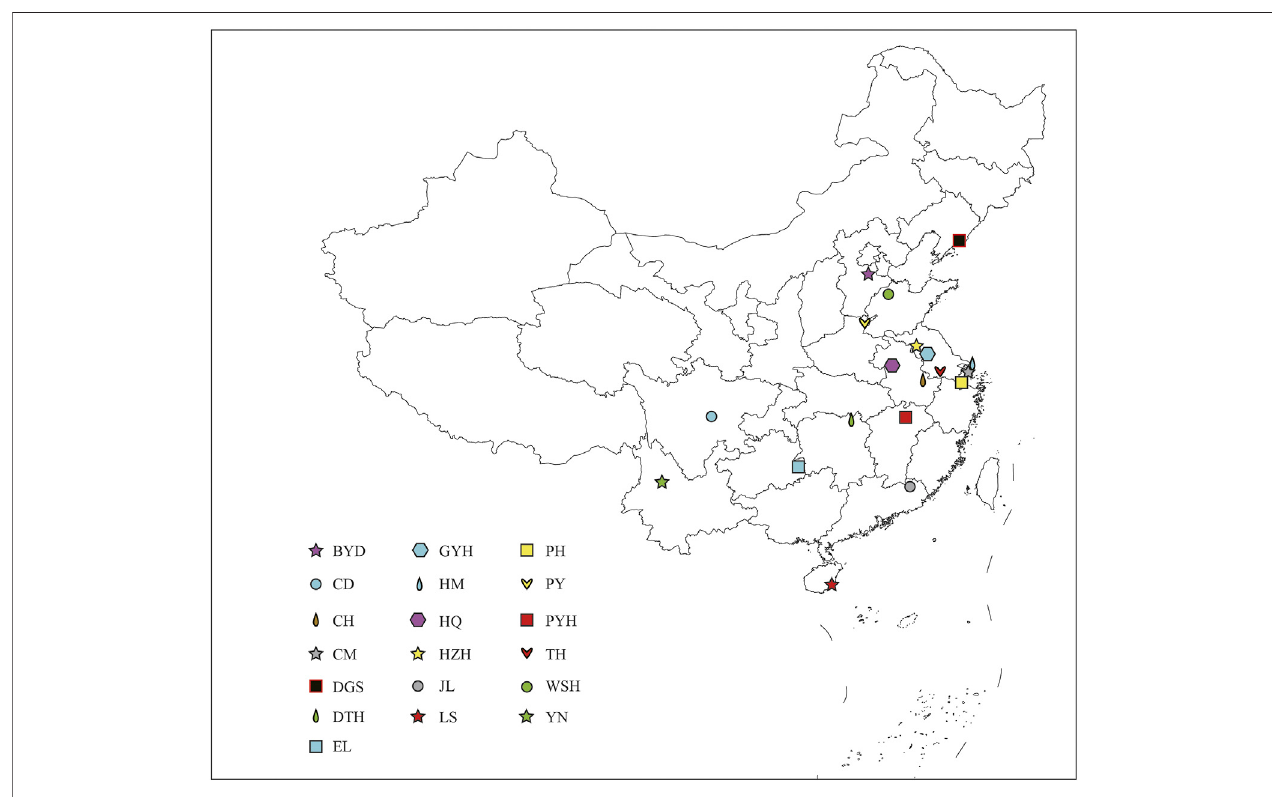
FIGURE 1 | Sampling sites of 19 populations in China. The abbreviations represent the sampling sites: BYD, Baiyangdian Lake; CD, Chengdu City; CH, Chaohu Lake; CM, Chongming Island; DGS, Dagushan; DTH, Dongting Lake; EL, Eli village; GYH, Gaoyou Lake; HM, Haimen City; HQ, Huoqiu County; HZH, Hongze Lake; JL, Jiaoling County; LS, Lingshui County; PH, Pinghu City; PY, Puyang City; PYH, Poyang Lake; TH, Tai Lake; WSH, Weishan Lake; YN,